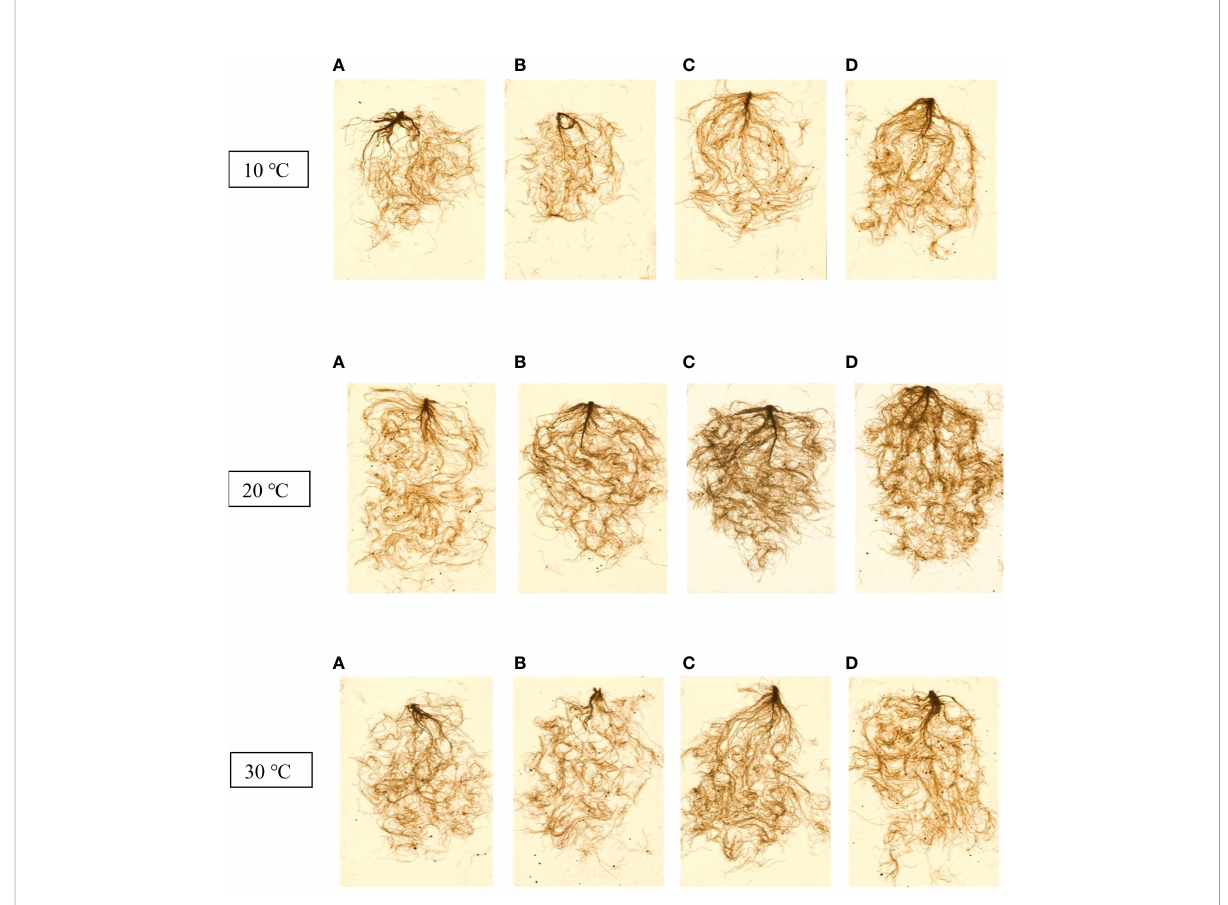
FIGURE 11 7-week-old canola root images for 10, 20 and 30 °C, respectively. (A) Control, (B) Thu1 (10 -7 M Th17), (C) Thu2 (10 -9 M Th17), (D) : Thu3 (10 -11 M Th17).